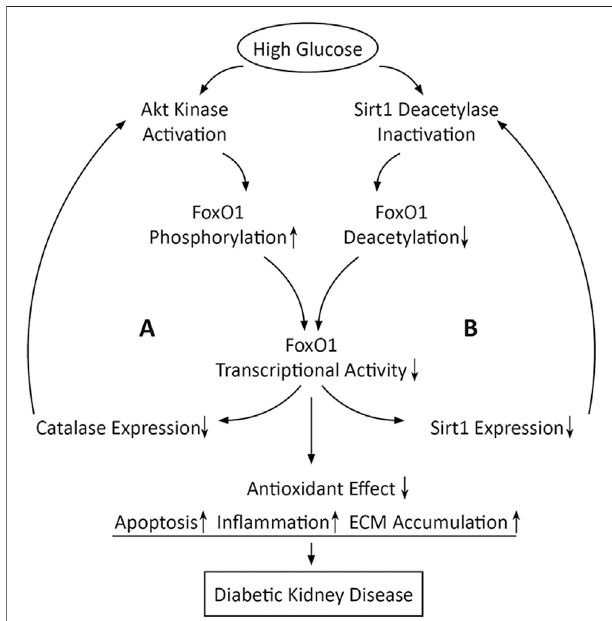
FIGURE 3 | Schematic diagram shows that high glucose may induce two positive feedback loops in which FoxO1 inactivation is involved. Loop A is